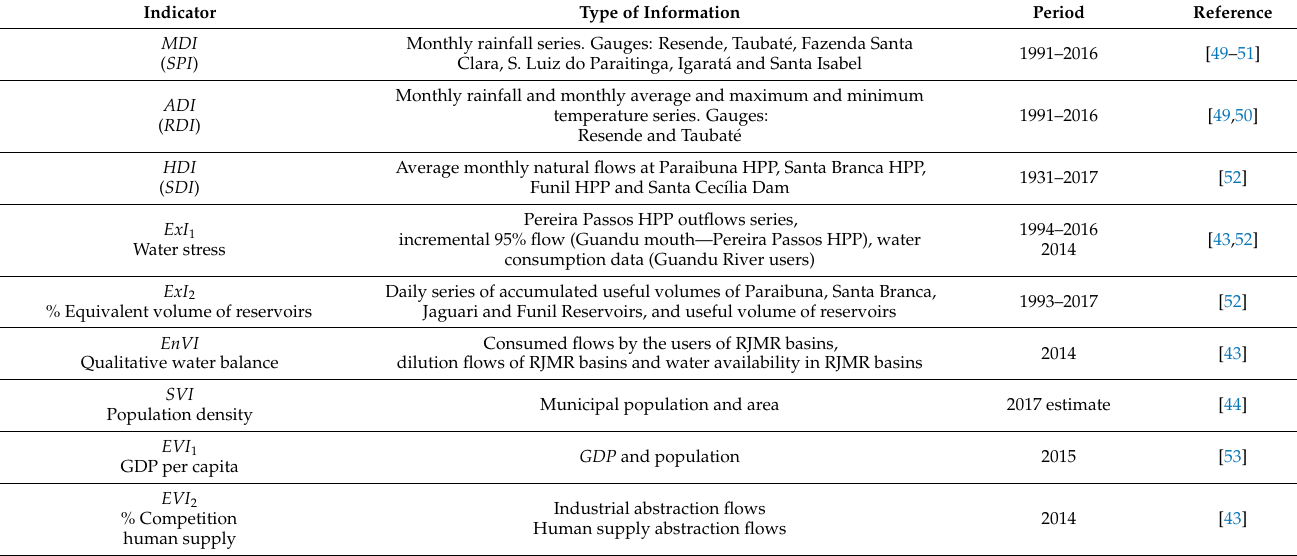
Table 7. Data used for W-ScaRI